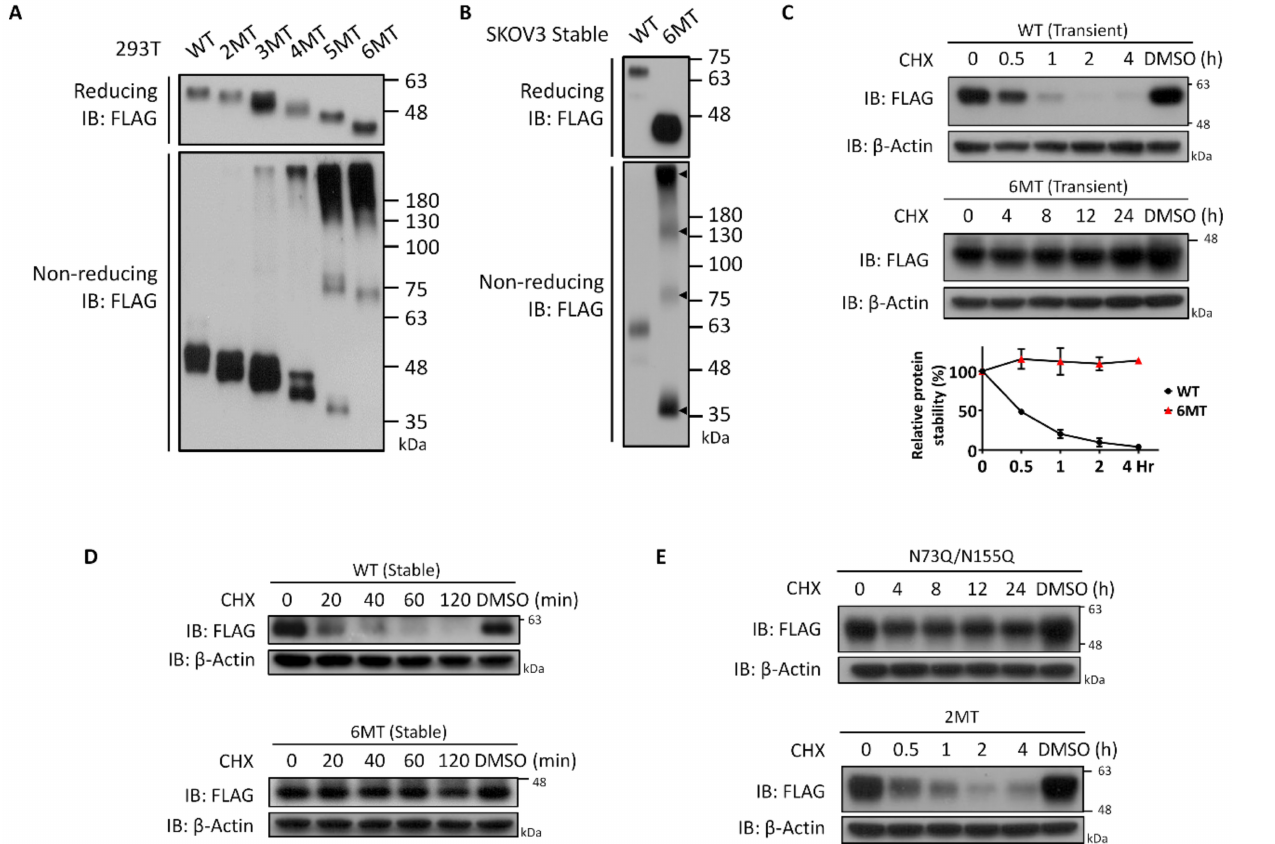
Figure 5. Multimer formation and protein stability of NEGR1 mutants. ( A ) Non-reducing SDS-PAGE analysis. The 293T cell lysates expressing NEGR1 mutant proteins were subjected to SDS-PAGE under non-reducing conditions, followed by immunoblotting using anti-FLAG antibody. ( B ) Non-reducing SDS-PAGE using SKOV3 stable cells expressing WT or 6MT. ( C ) To determine the half-lives of NEGR1 WT and 6MT, 293T cells were incubated in the presence of cycloheximide (CHX, 50 µ g/mL) after transfection. Intensities of bands were quantified by ImageJ and normalized to β -actin. Data are means ± standard deviation ( n = 3). ( D ) Half-life determination using SKOV3 cells stably expressing NEGR1 WT or 6MT. ( E ) After 293T cells were transfected with N73Q/N155Q and 2MT for 24 h, cells were incubated with 50 µ g/mL